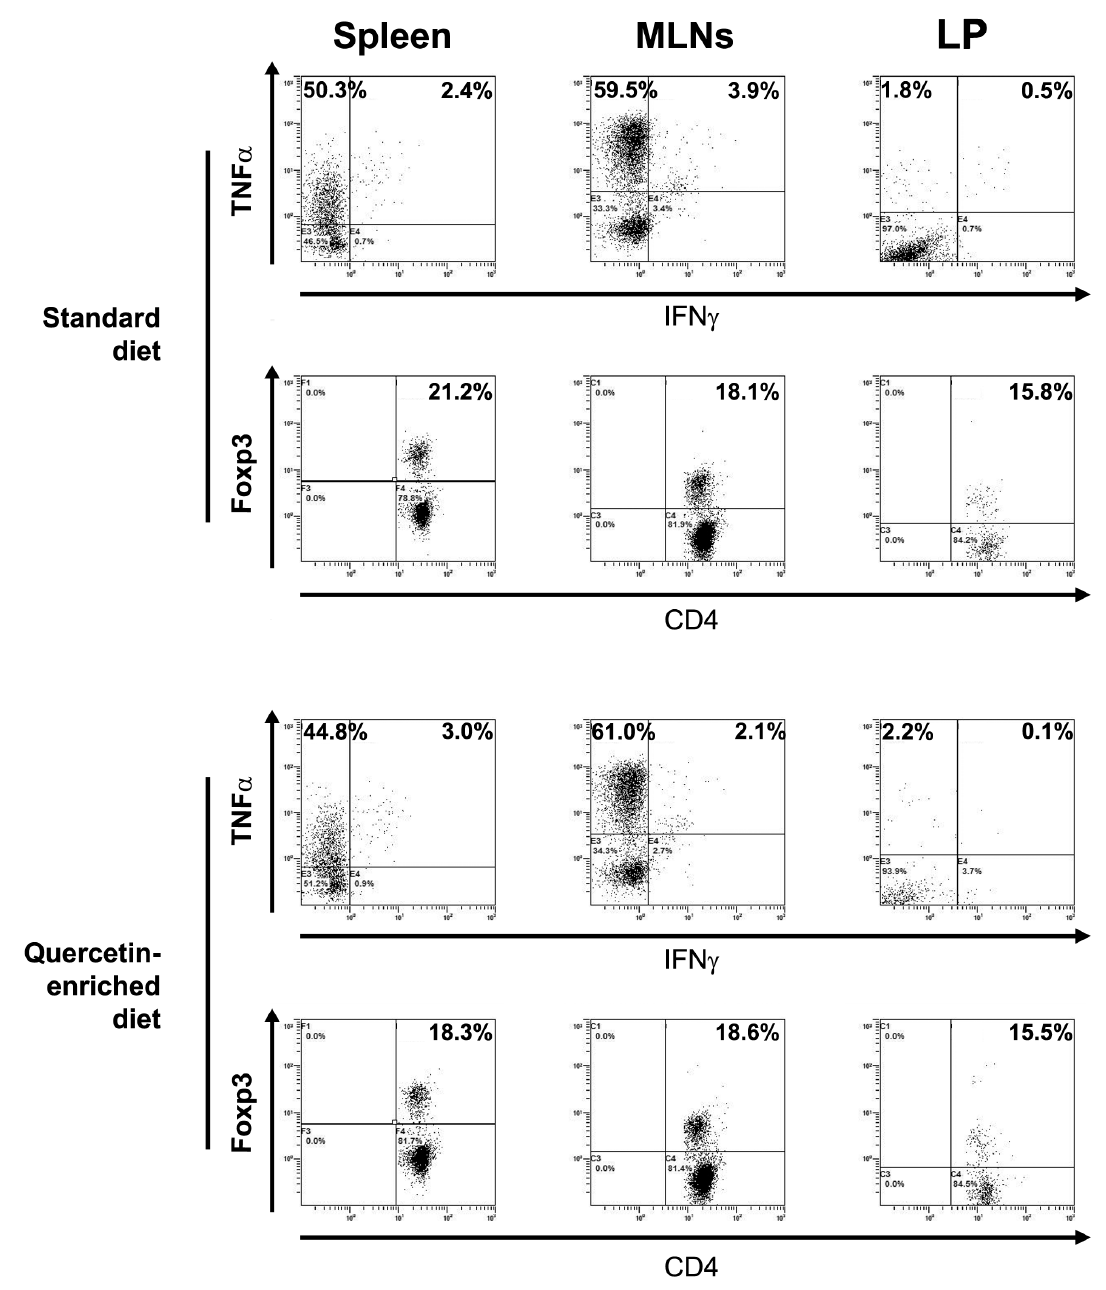
Figure 4. T cell polarization in mesenteric lymph node (MLN), spleen, and lamina propria (LP). Representative intracellular staining of CD4 + T cells. No significant differences could be observed in the percentage of TNF α + , IFN γ + , or Foxp3 + cells in mice treated with standard or quercetin-enriched diet ( n = 3).